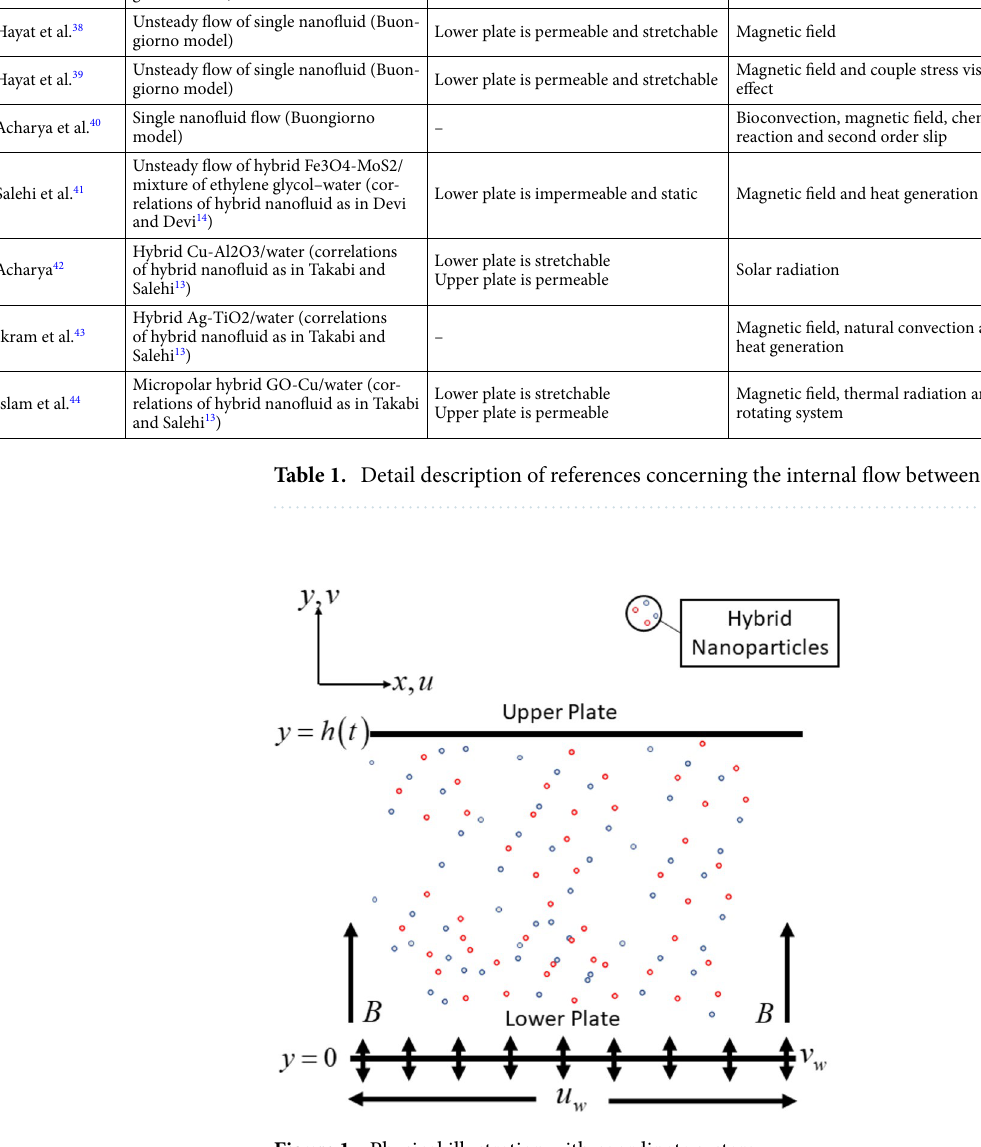
Figure 1. Physical illustration with coordinate